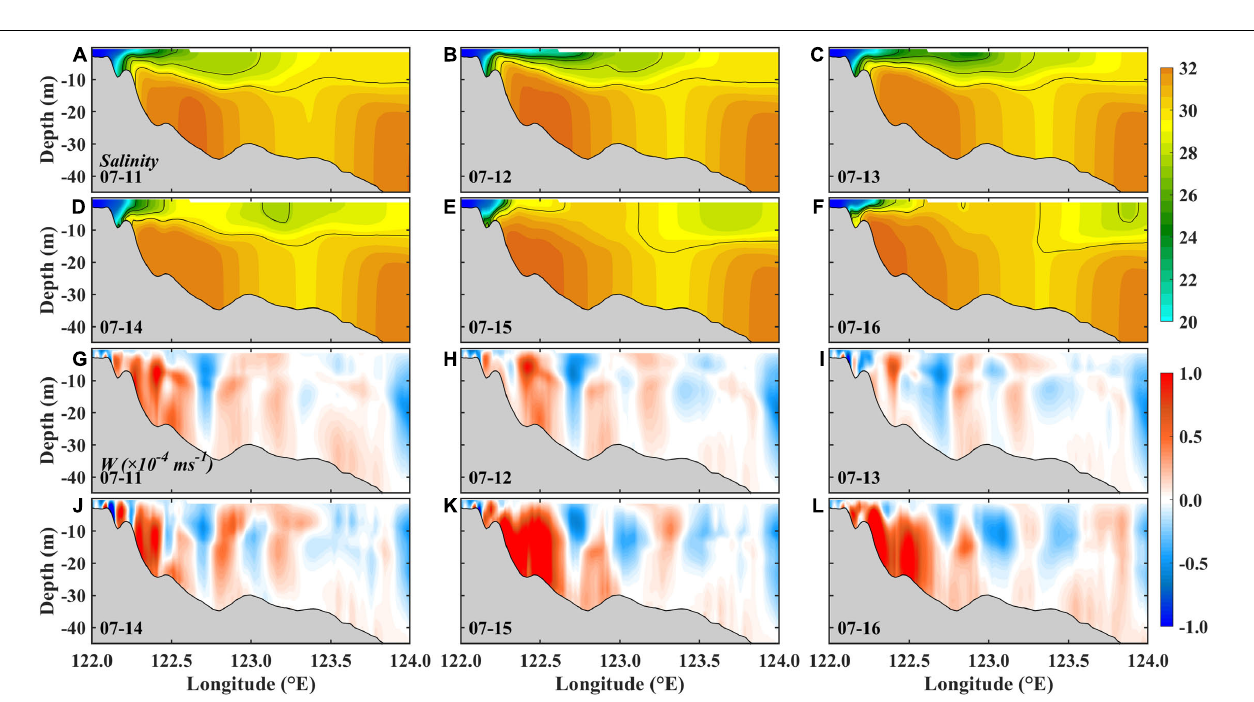
FIGURE 7 | (A–F) The daily-averaged salinity (black lines indicate 24, 26, 28, and 30 psu) and (G–L) vertical velocity (unit: × 10 − 4 ms − 1 ) along the cross-section A from July 11 to 16, 2006.